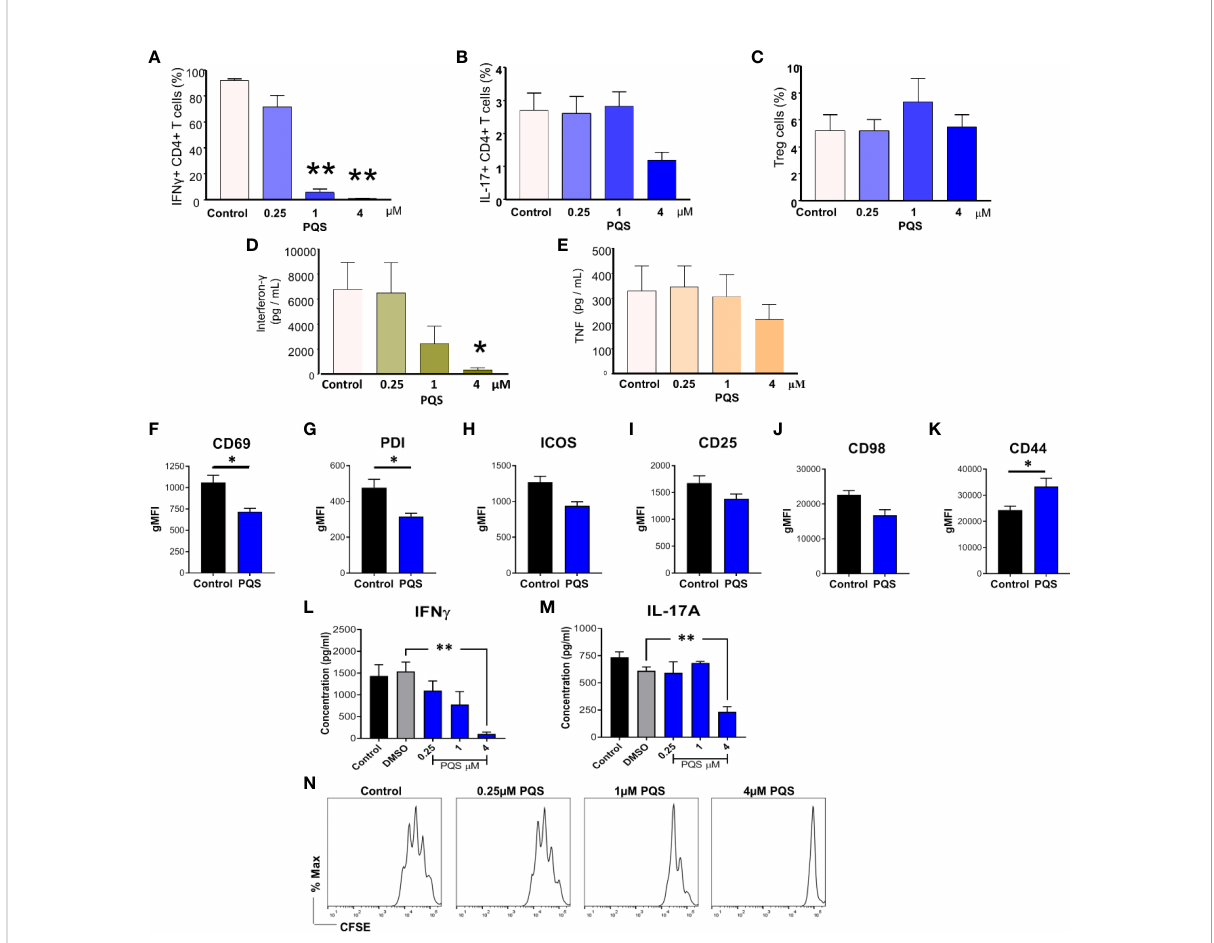
FIGURE 2 PQS reduces IFN- g and IL-17 production. T cells isolated from the spleens of mice with CIA, stimulated with anti-CD3 (5 m g/mL) in the absence or presence of PQS for 48 h. Percentage of CD4+ cells expressing (A) IFN- g , IL-17+ and (C) FoxP3+ Treg; n = 5. (D) IFN- g and (E) TNF secretion from CD4+ splenocytes from CIA mice cultured ex vivo with anti-CD3 in the presence of PQS; n = 4. (F – K) Cell surface marker expression on naïve murine T cells stimulated (anti-CD3) in the presence of PQS (n = 4). Secretion of (L) IFN- g and (M) IL-17A from cells differentiated to Th1 or Th17, respectively, was inhibited by PQS at 4 m M (n = 3). *p<0.05, **p<0.01, relative to DMSO. (N) Representative histogram of CFSE-labelled CD4 + cell proliferation indicating inhibition by PQS at 1 and 4 m M. * p<0.05, ** p<0.01, n = 3. ( A-F : unpaired t test; G, H : One way ANOVA and Bonferroni multiple comparison